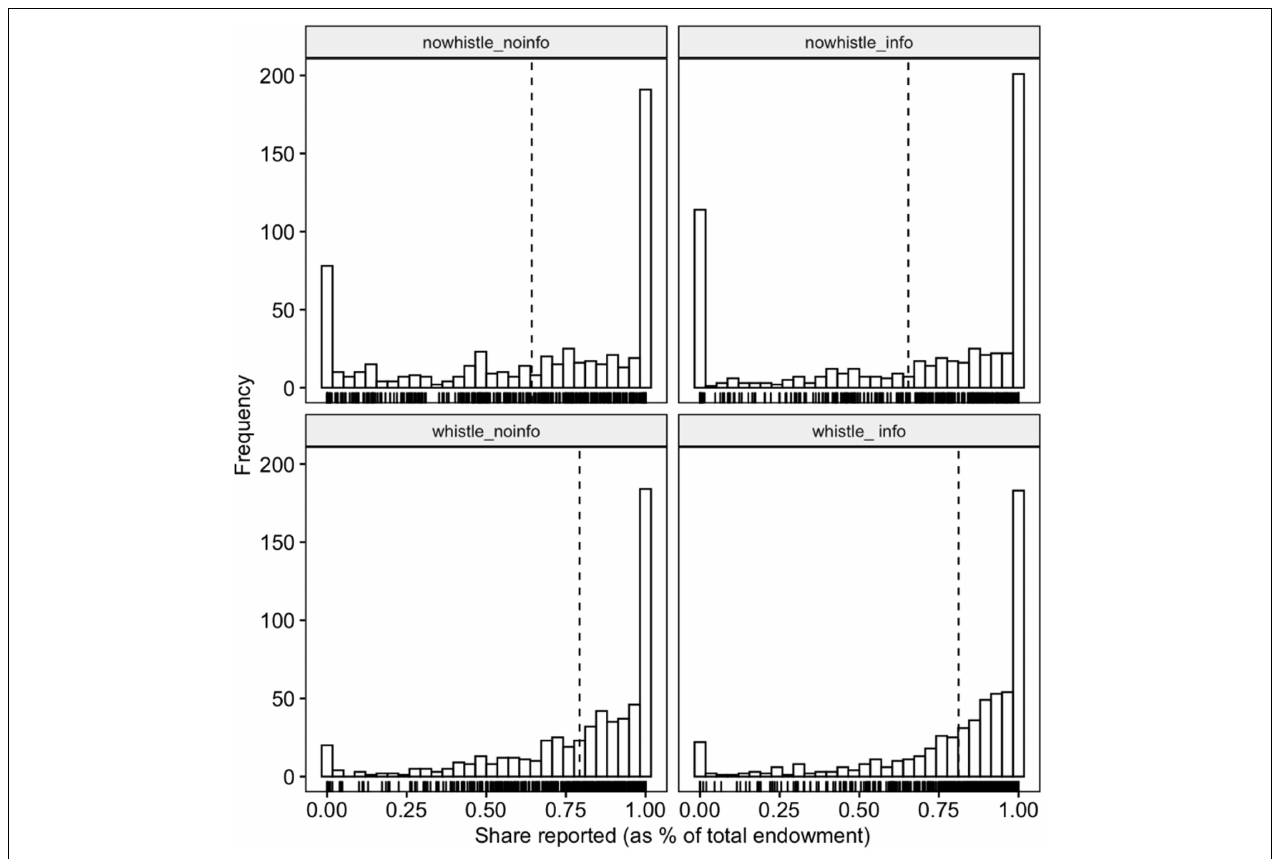
FIGURE 2 | Frequency of proportion of reported income per treatment.